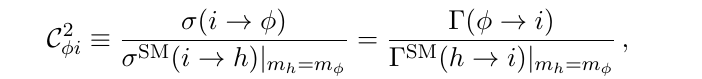
Figure 5 . This plot shows the dilaton production cross section normalized by ggF for center of mass energy 13 TeV and 27